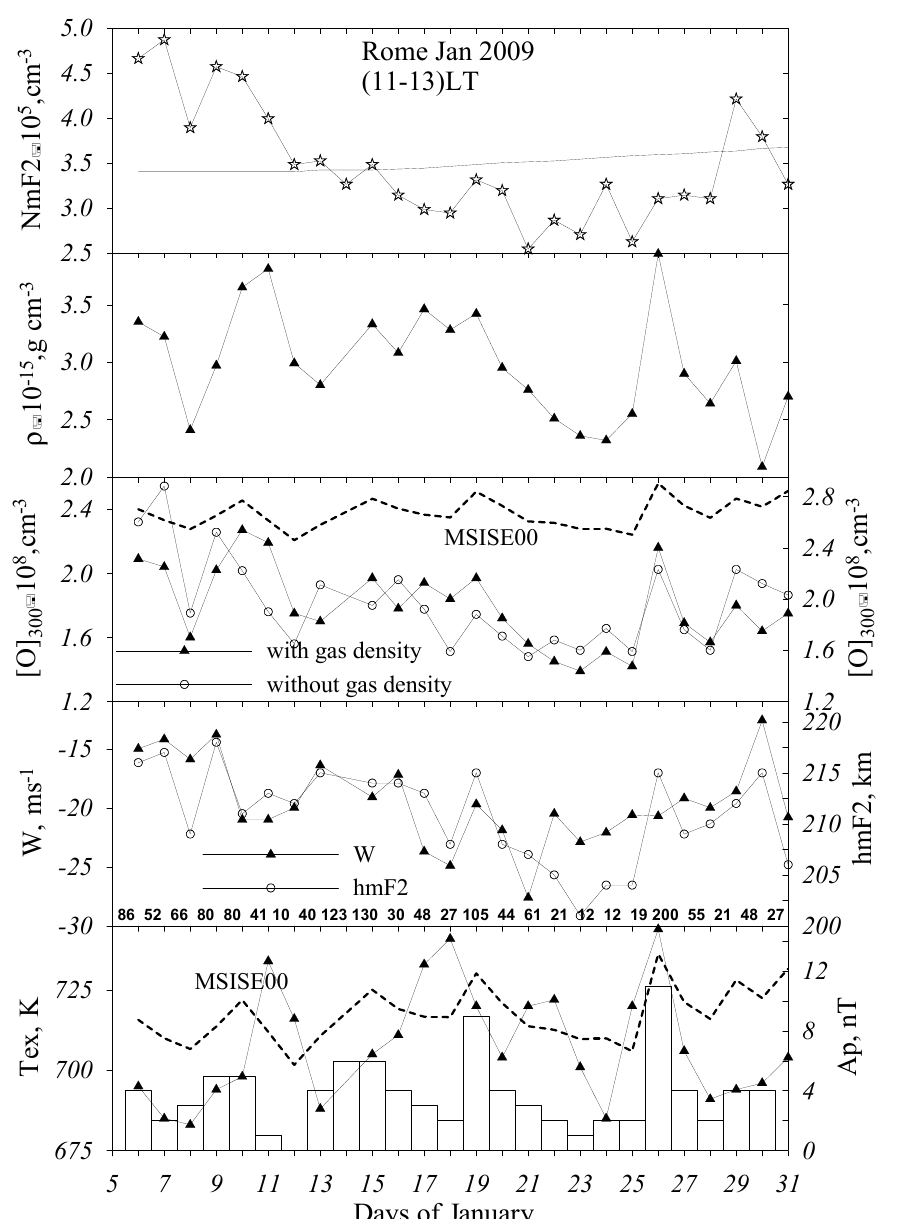
Figure 4. The observed values averaged over (11–13) LT N m F 2 at Rome (solid line in top panel— monthly median N m F 2 ), measured with CHAMP neutral gas density reduced to the location of Rome and 12 LT, retrieved atomic oxygen at 300 km, vertical plasma drift, h m F 2 , and exospheric temperature are given in the plot. The daily AE values are given in the second panel and the daily Ap indices in the bottom panel. Dashed lines—MSISE00 model variations (right y -axis for [O]). Atomic oxygen was retrieved with (left y -axis) and without (right y -axis) fitting the observed neutral gas density.